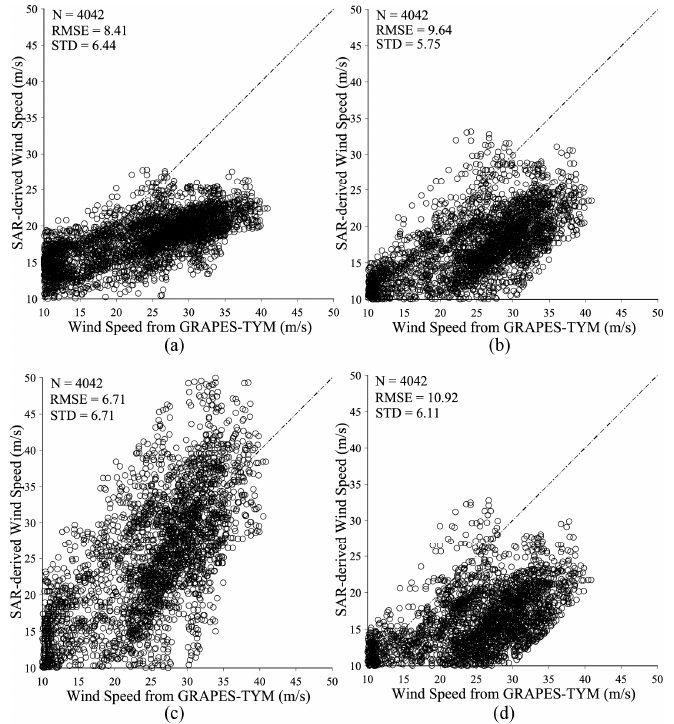
Figure 12. Comparison between SAR-derived wind speeds using the existing three algorithms and GRAPES-TYM winds. ( a ) using the algorithm proposed in [20]. ( b ) using the algorithm proposed in [22]. ( c ) using the algorithm proposed in [23]. ( d ) using the algorithm proposed in [25].